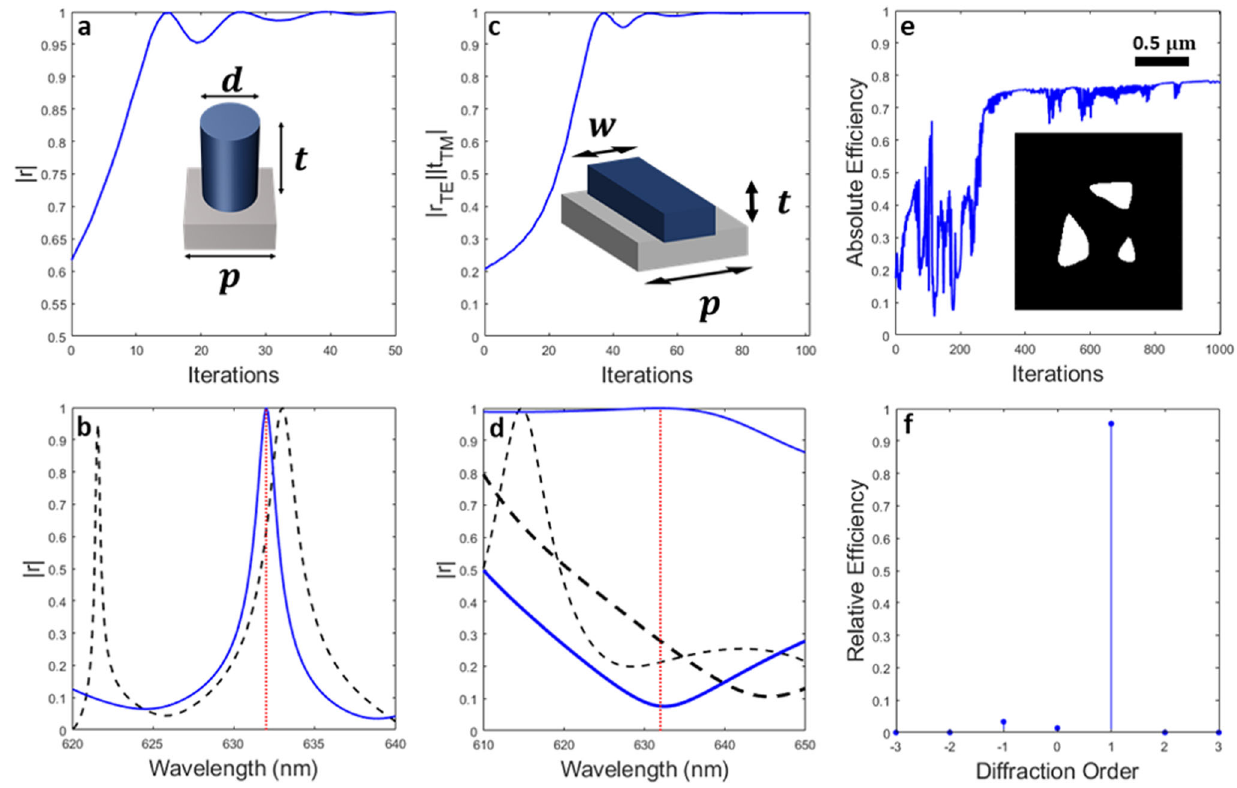
Fig. 3 Optimization results for single layer metagrating designs. We maximize the re fl ectivity ( a ) of a TiO 2 cylindrical nanopost ( a inset) by optimizing the diameter, inducing a blueshift of the resonance ( b ), where the black dashed and blue solid curves are the initial and optimized designs, respectively, and the red dotted line denotes the design wavelength of 632nm. In ( a ), d , t , and p denote the diameter, thickness, and pitch of the grating as shown. In ( c ), we maximize the transverse electric (TE) re fl ectivity r TE while maximizing the transverse magnetic (TM) transmission t TM of a TiO 2 rectangular line-based unit cell ( c inset) at a design wavelength of 632nm. In ( d ), the results of this optimization are shown where the red dotted line denotes the design wavelength, the black thin (thick) dashed line represents the initial TE (TM) re fl ectivity, while the blue thin (thick) solid line stands for the optimized TE (TM) re fl ectivity. The optimized design achieved an extinction ratio of transmitted TE to TM light of 22dB. In ( a ), w , t , and p denote the width, thickness, and pitch of the grating as shown. We also topology optimize ( e ) a single-layer silicon grating at 1550nm ( e inset shows the permittivity pro fi le, with silicon in white and SiO 2 in black), achieving an absolute ef fi ciency of 77% of light directed into the fi rst diffraction order (75° de fl ection) and a relative ef fi ciency of 95% ( f